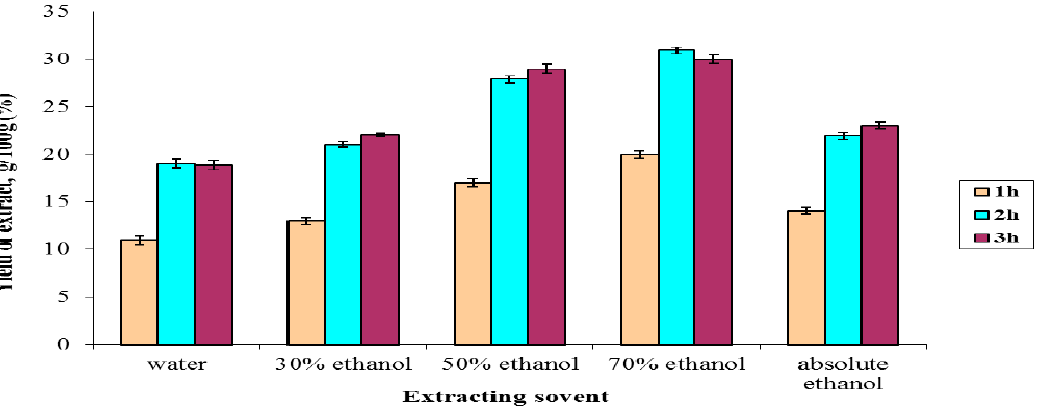
Figure 1. Graphical comparison of the yields of different extractions of the roots of G. collinum .